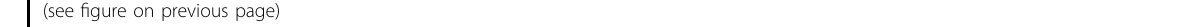
Fig. 1 Mutations in PNH and their clinical correlations. A Heatmap of mutations in myeloid cancer-related genes detected in PNH. One hundred seventy-eight myeloid cancer-related genes were tested by whole-exome sequencing. Every column represented a patient, and every row represented a mutated gene. Red color indicated the detection of mutated gene in this patient. The bar graph above the heatmap showed the number of mutations in each patient. The bar graph on the right side of the heatmap showed the frequency of the type of mutations in each gene. B Negative correlation of PNH clone size with frequency of uncommon mutations in PNH. Patients were divided into different groups ( ≤ 40%, 41 – 80%, >80%) according to their PNH clone size. Genes commonly mutated in and associated with a poor prognosis in aplastic anemia were uncommonly mutated in PNH. These mutated genes were lumped together. The frequency of these mutations declined in PNH as the size of PNH clone increased. C Relationship between gene mutations and sites of thrombosis in PNH. The mutation rates of SRRD and EGR4 in different subgroups of patients were shown in ( a ) and ( b ), respectively. The numbers on the columns represented the number of patients in each subgroup. Logistic regression revealed that mutation in SRRD was an independent risk factor for visceral thrombosis ( p = 0.032) whereas mutation in EGR4 was an independent risk factor for myocardial infarction ( p = 0.007). D Negative correlation between PNH clone size and frequency of mutations in thrombosis-related genes in PNH. This fi gure elucidates the PNH clone size calculated by FLAER negative granulocytes as well as the number of mutation in candidate genes concerning thrombosis in 13 patients with thrombosis events. The blue line is the fi tted line of the correlation